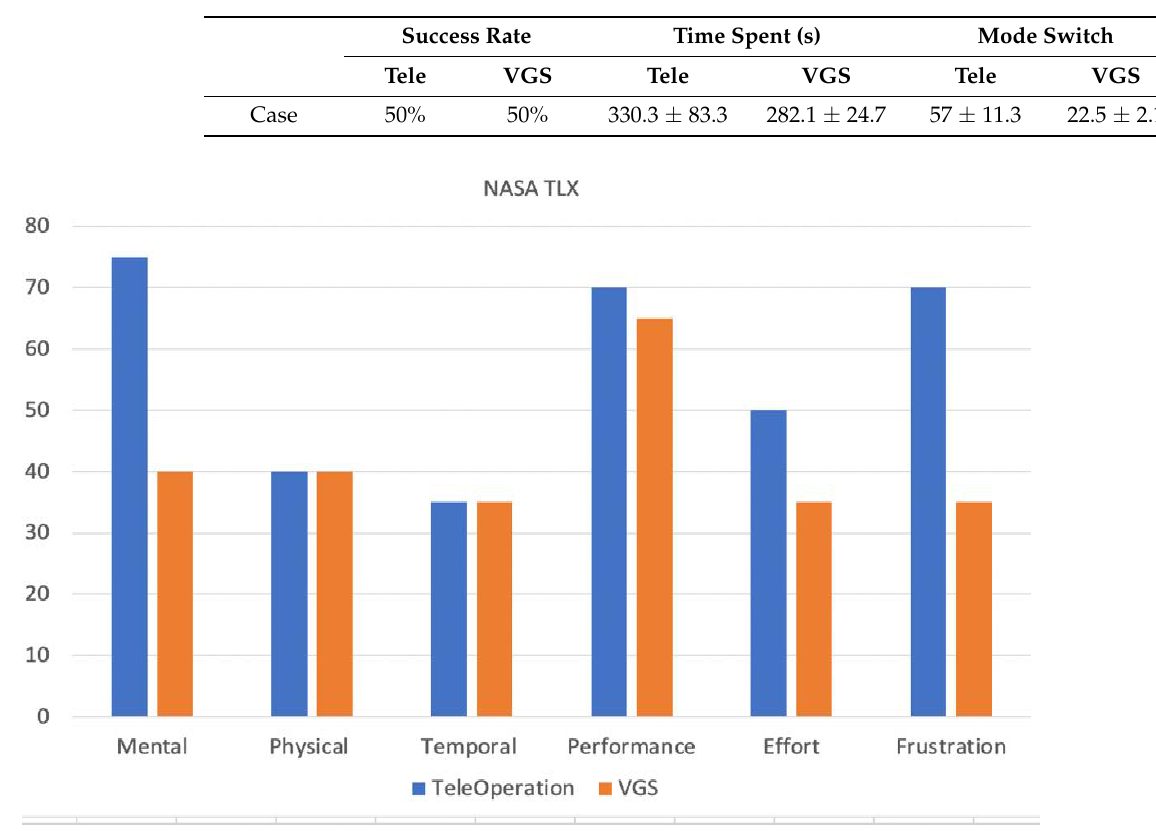
Figure 6. NASA-TLX ratings for both control methods by the case